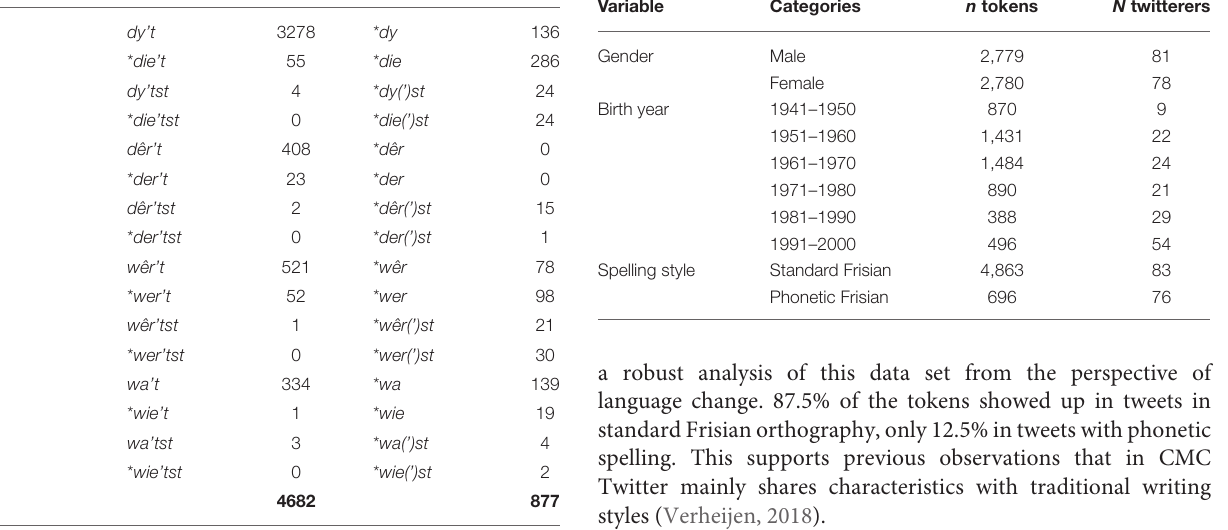
TABLE 4 | Distribution of Frisian relative pronouns ( dy’t ), ( dêr’t ), ( wêr’t ), and ( wa’t ) in the final data set ( n = 5,559, distributed over 159 Twitterers). Target variable